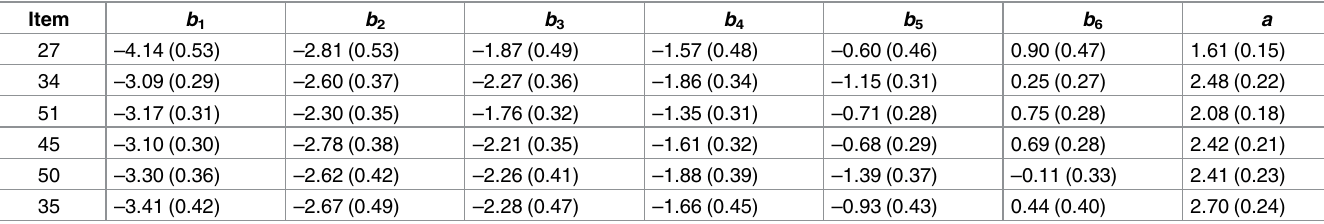
Table 3. Intellectual humility–Open-mindedness item parameter estimates.